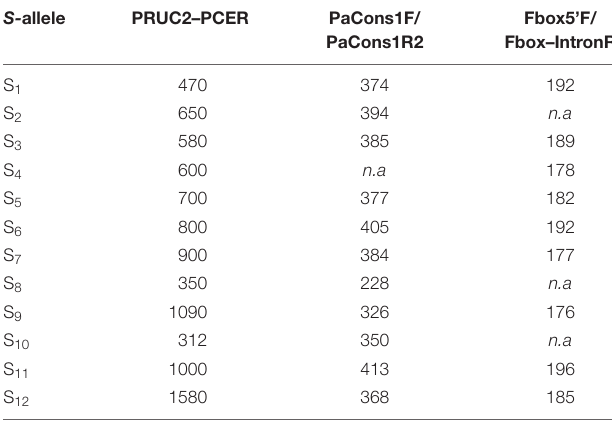
TABLE 4 | Sizes of S- alleles amplified in hexaploid P. domestica and P. insititia with three primers pairs. S- allele